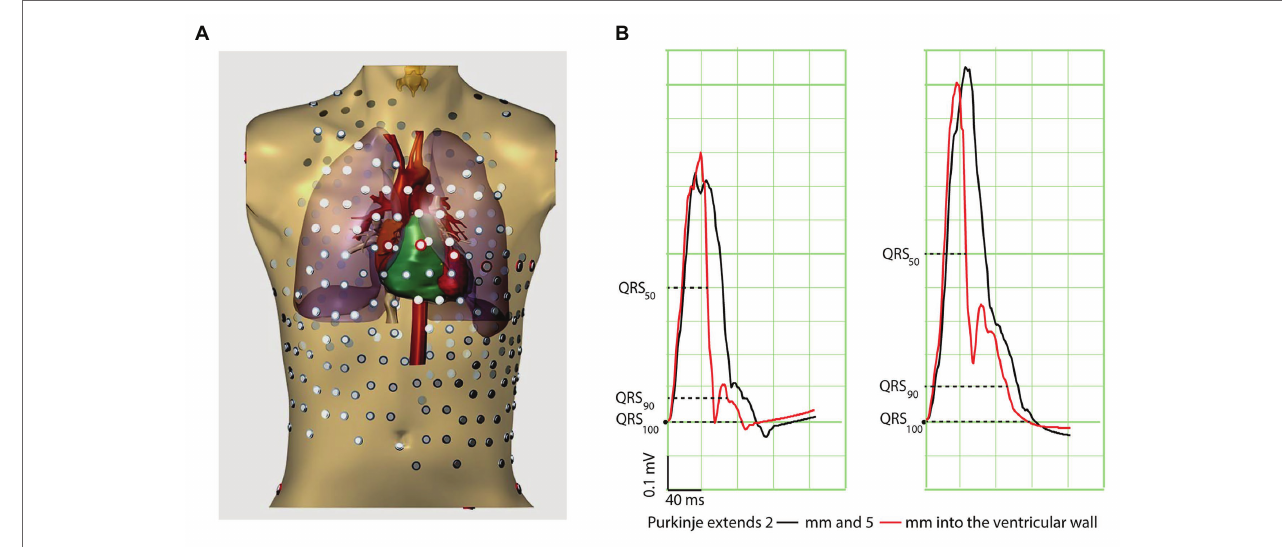
FIGURE 1 | Computer simulations show that penetration of Purkinje fibers into the ventricular wall results in QRS slurring and short QRS50. (A) Torso model used for simulation. (B) The traces show simulated electrocardiograms (Lead II and III) with Purkinje fibers penetrating 2 mm (black) and 5 mm (red) into the ventricular wall. The dashed lines refer to the QRS duration at 50, 90, and 100% at 5 mm penetrance into the ventricular wall. Note that these moments of QRS50, QRS90, and QRS100 slightly differ at 2 mm penetrance because of different QRS